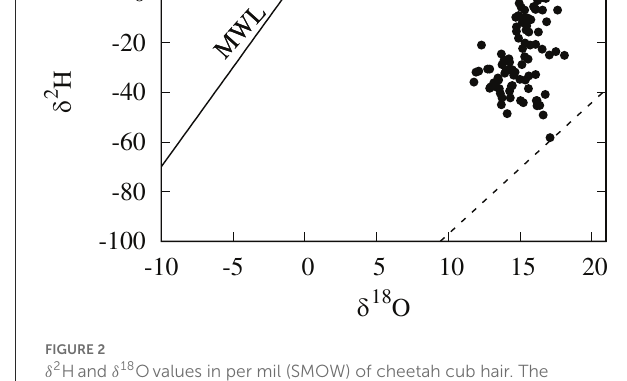
FIGURE2 δ 2 Hand δ 18 Ovalues in per mil (SMOW) of cheetah cub hair. The dashed line is the relationship for domestic and wild cats in North America (Koehler and Hobson, 2019). Also shown is the global meteoric water line (MWL) of Craig